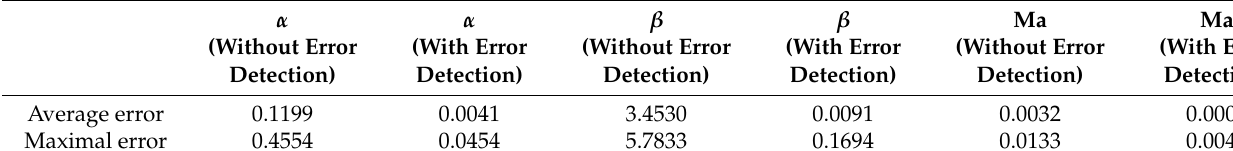
Figure 14. Port locations. Table 6. Comparisons of the prediction results with and without error detection.